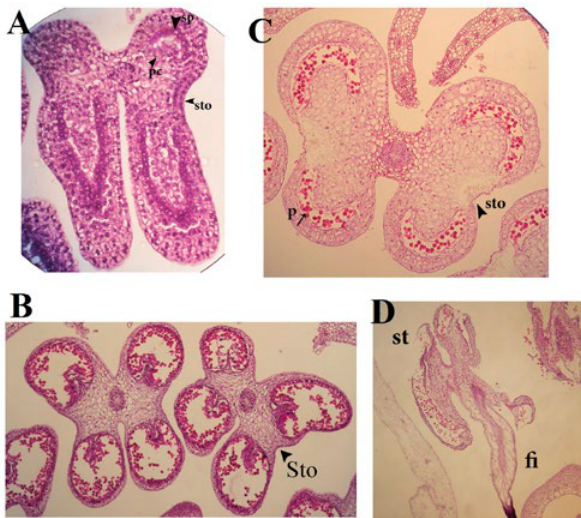
Figure 3. Transverse section of anther in different stages of develop- ment. (A) Young anther; (B) Second meiotic division in anther; (C) Anther at the binucleate pollen grain stage; (D) Longitudinally dehis- cent anther in cross section (fi – filament; p – pollen; pc – placen- toids; sp – primary sporogenous layer; st – stamen; sto – stomium).